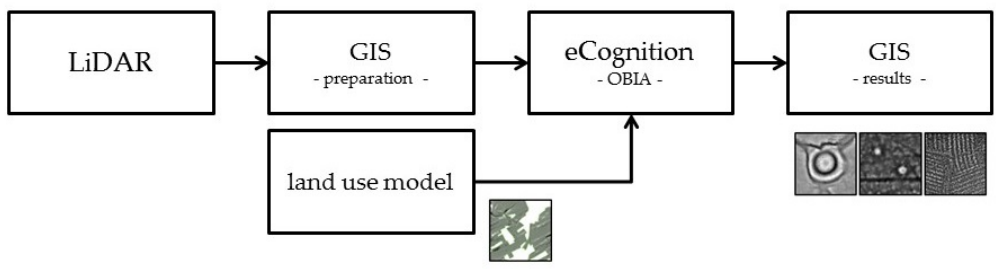
Figure 6. Overview of the general workflow for the detection of field monuments